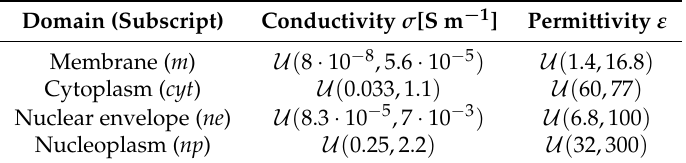
Table 3. Assumptions for the dielectric properties of eukaryotic cells as reported in [65]. The uniform distribution is denoted by U .